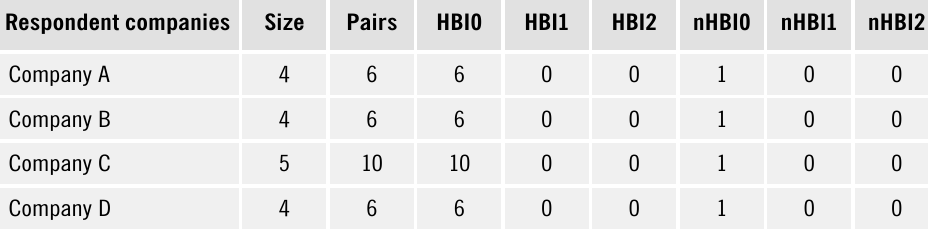
Table 14. Honest broker indices of the respondent companies with weighted relations Respondent